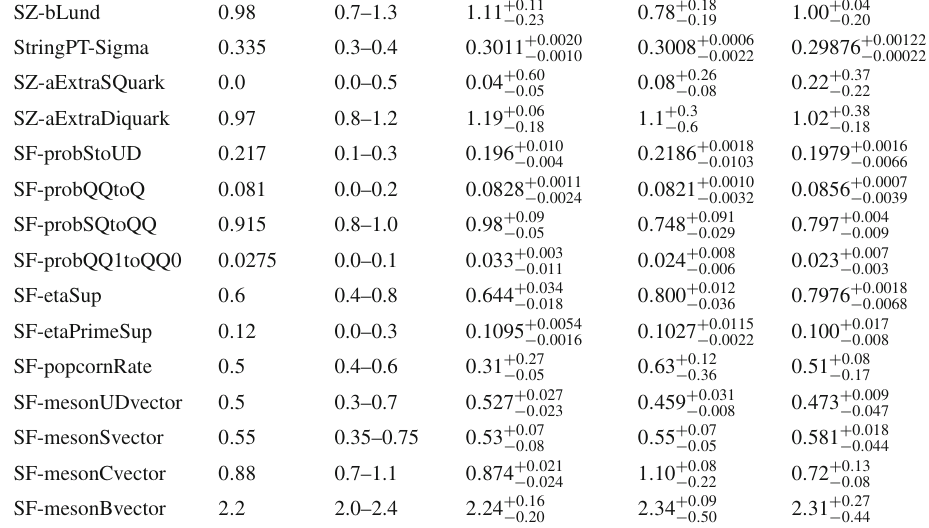
Table 3 Result of the retuning of the Herwig 7 event generator employing the default hadronisation model (cluster model). The 22 dimensional parameter space was tuned with three sub-tunes and three iterations. Shown are the default values (corresponding to the Qtilde shower tune) as well as the parameter range and the tuning result for both showers. The errors given are determined by the method described in Sects. 3.4 and 3.3 and must not be confused with neither theoretical not experimental